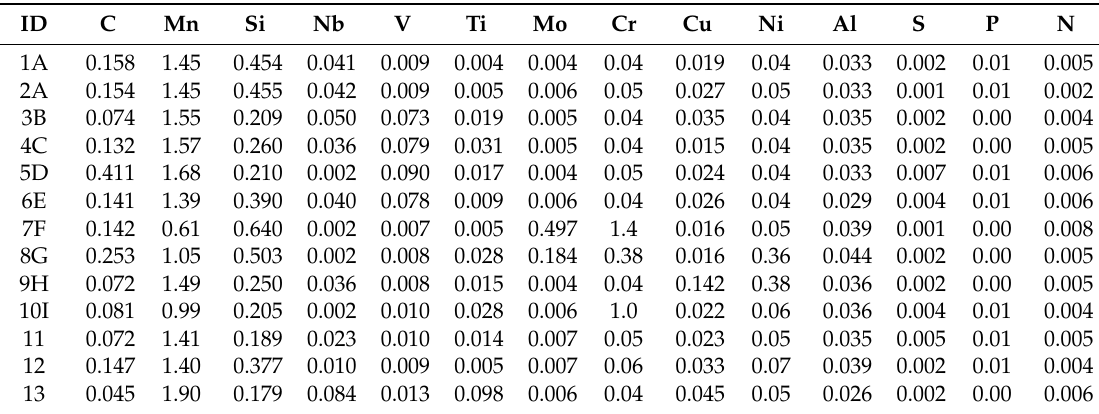
Table 1. Industrial sample compositions.